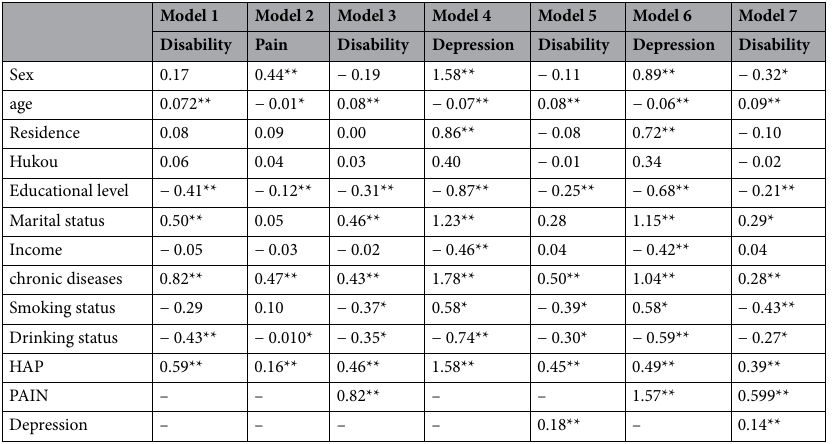
Table 3. Simplified simple mediation analysis results (N = 5471). Simple mediation A (HAP → pain → disability) include Model 1, Model 2 and Model 3; simple mediation B (HAP → depression → disability) include Model 1, Model 4 and Model 5; **p < 0.05, **p < 0.01; Serial Mediation (HAP → pain → depression → disability) include Model 2, Model 6, Model 1 and Model 7; *p < 0.05, **p < 0.01.